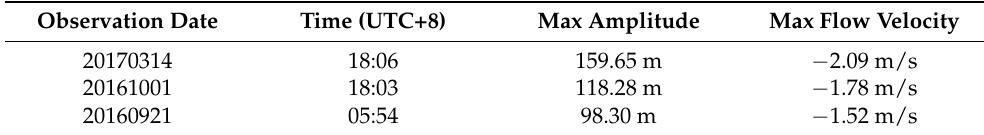
Table 1. Characteristic data for ISWs on three different days.